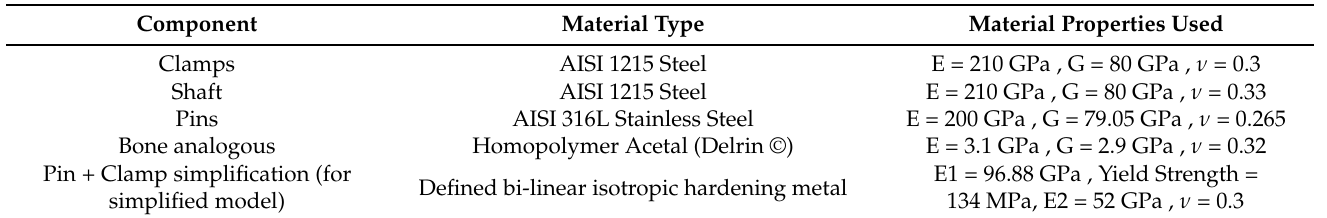
Table 2. Material properties of each component, used for simulations and calculations.